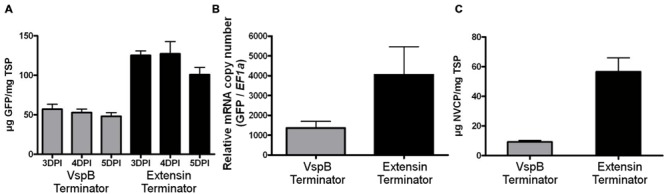
Extensin terminator increases transgene production and mRNA accumulation. (A) Fluorimetric analysis of GFP production. N. benthamiana leaves were agroinfiltrated with BeYDV vectors containing either the vspB terminator (gray bars, pBYGFP.R) or tobacco extensin terminator (black bars, pBYGFP.EFR). Leaves from agroinfiltrated tissue were harvested at 3–5 DPI and analyzed for GFP production by spectrofluorimetry using excitation and emission wavelengths of 485 and 538 nm. GFP production was normalized by total soluble protein. Columns represent means ± SD from six independently infiltrated samples. (B) Total RNA from agroinfiltrated N. benthamiana leaves were analyzed for GFP mRNA accumulation by quantitative RT-PCR at 3 DPI. Translation elongation factor 1α was used as an internal loading control. Columns represent means ± SD from four independent infiltrated samples. (C) NVCP production. Protein extracts from N. benthamiana leaves agroinfiltrated with either the vspB terminator (gray bars, pBYNVCP.R) or the tobacco extensin terminator (black bars, pBYNVCP.REF) harvested at 3 DPI were analyzed for NVCP production by ELISA and normalized by total soluble protein. Columns represent means ± SD for nine independently infiltrated samples.